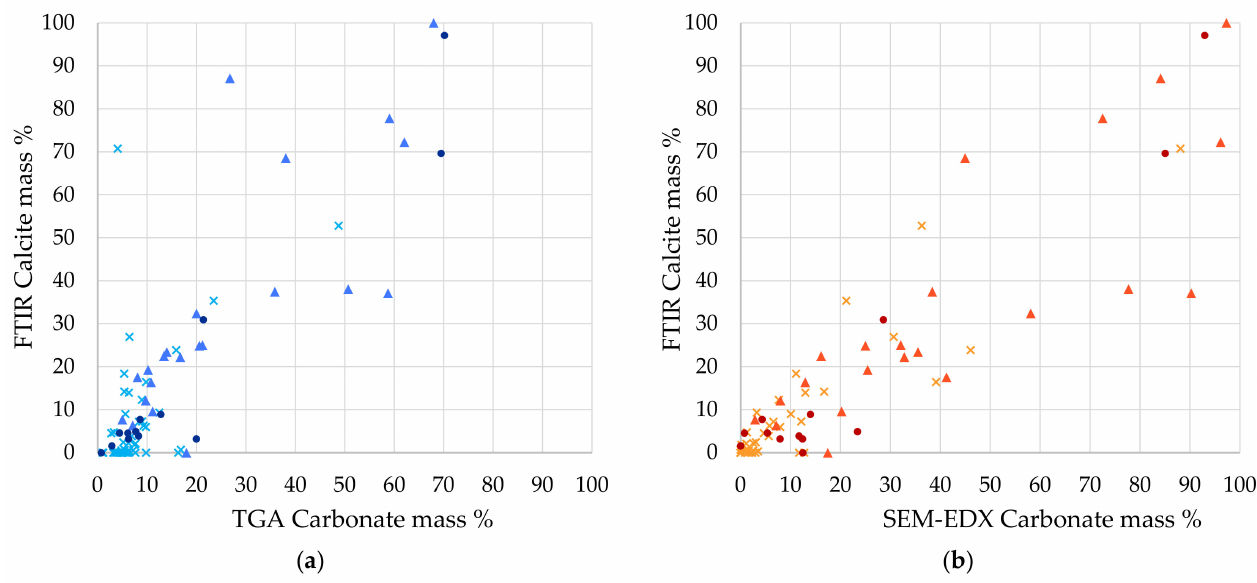
Figure 3. Comparison of FTIR-based calcite mass % and ( a ) TGA- or ( b ) SEM-EDX-based carbonate mineral mass % versus on corresponding PC and PVC filters from each sample set ( n = 85 each). In the figures, × = FTIR calcite mass below LOD, (cid:78) = between LOD and LOQ; • = above LOQ. In total, 37 of the 93 FTIR samples had calcite mass below the LOD, 28 samples were between LOD and LOQ, and 28 samples were above LOQ.